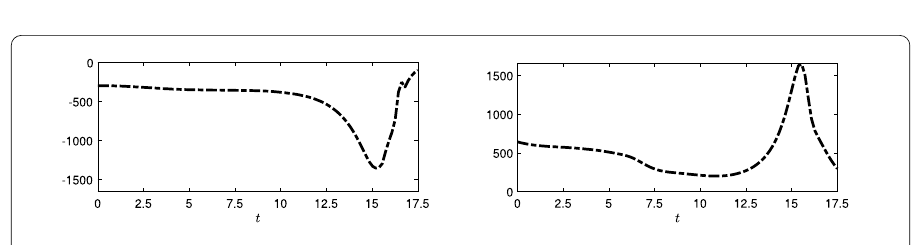
Figure 7 Optimal trading rate over the trading window t ∈ [0,17.5] for Z t ≡ –499.4 MWh and Y t ≡ 59.25 e /MWh (left) as well as Y t ≡ 13.98 e /MWh